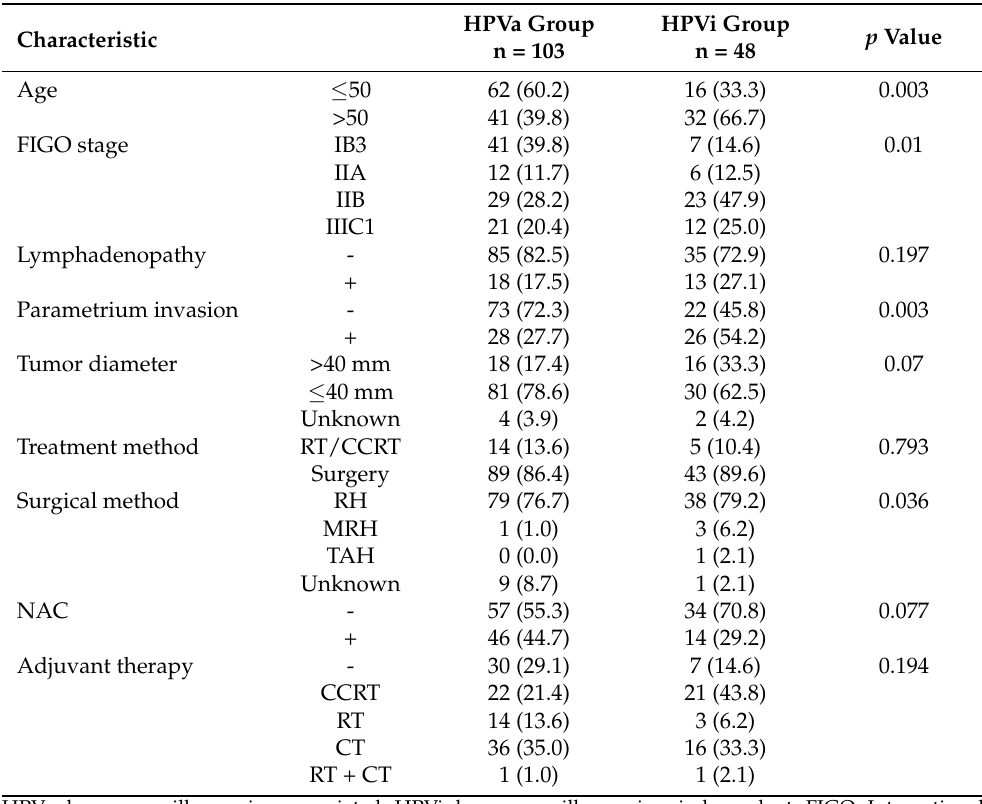
Table 1. Patient